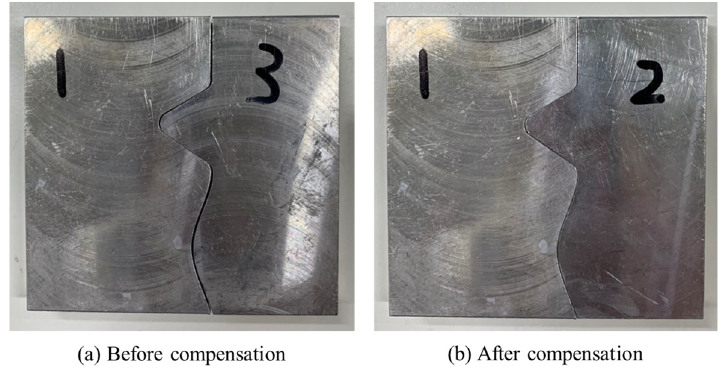
Figure 19. Comparison assembly complex mating before and after compensation.